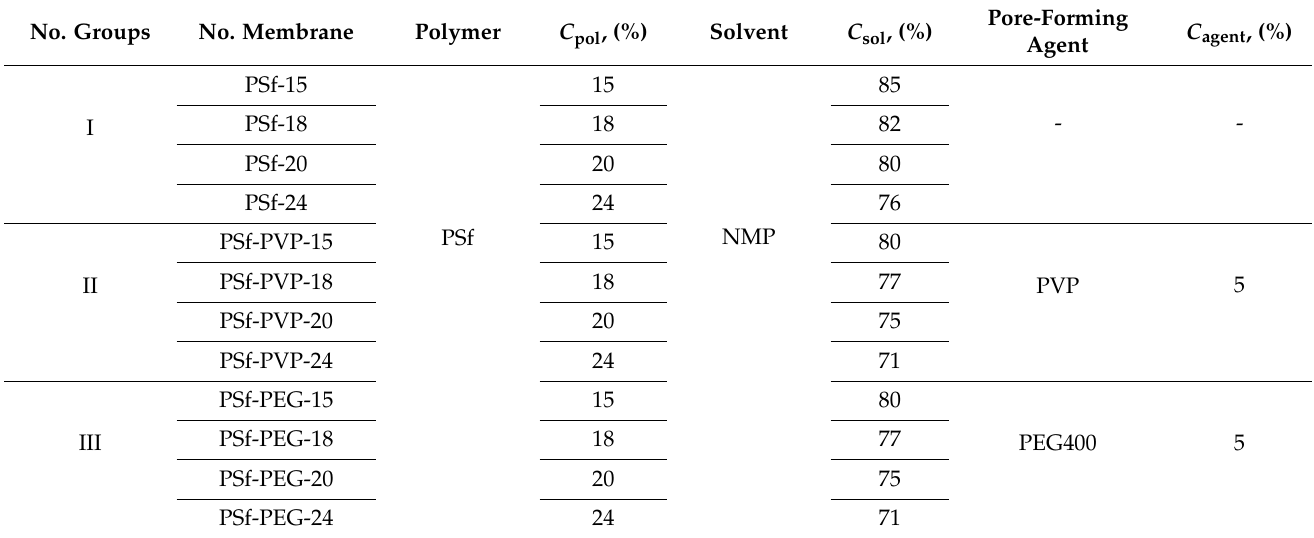
Table 1. Compositions of the studied casting